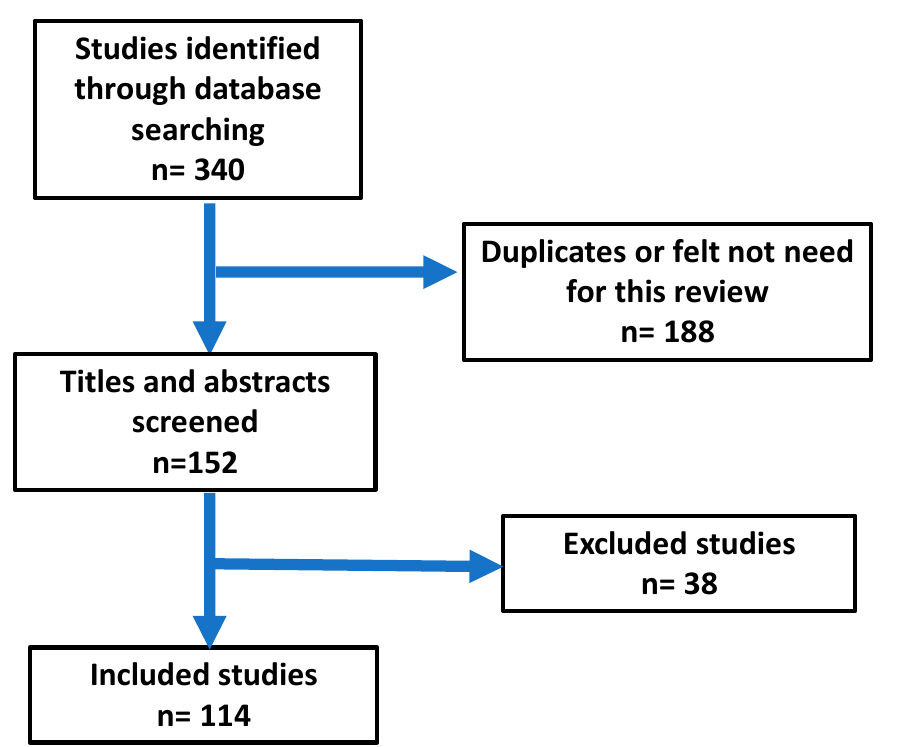
Figure 1. Results of the search of the